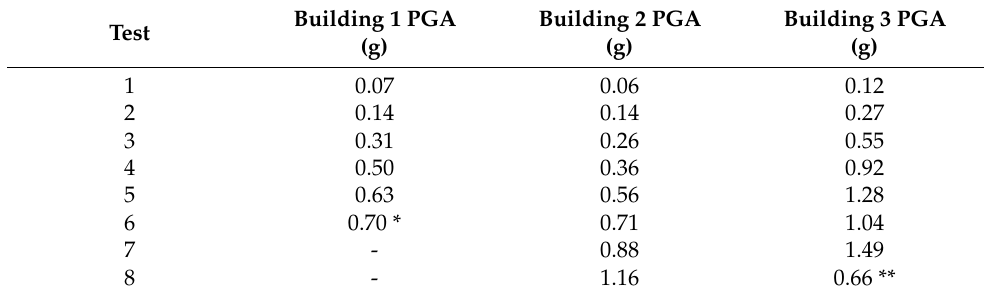
Table 3. Shake-table testing